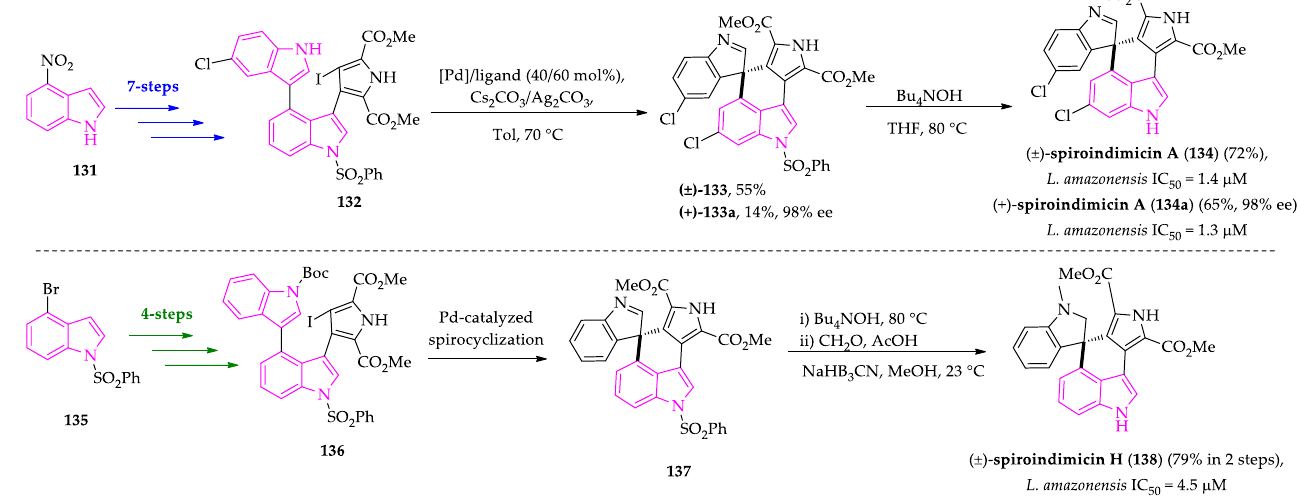
Figure 17. Hit-to-lead optimization of 3,5-disubstituted-7-azaindole NEU-1207 ( 129 ).